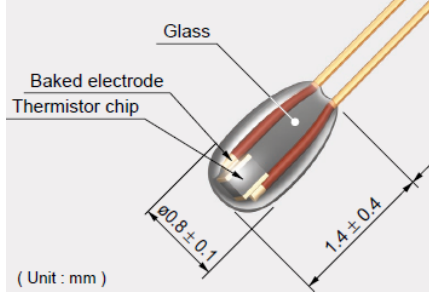
Figure 2. Closeup of the iMet-XF bead thermistor with dimensions and composition. Image provided by International Met (InterMet) Systems.